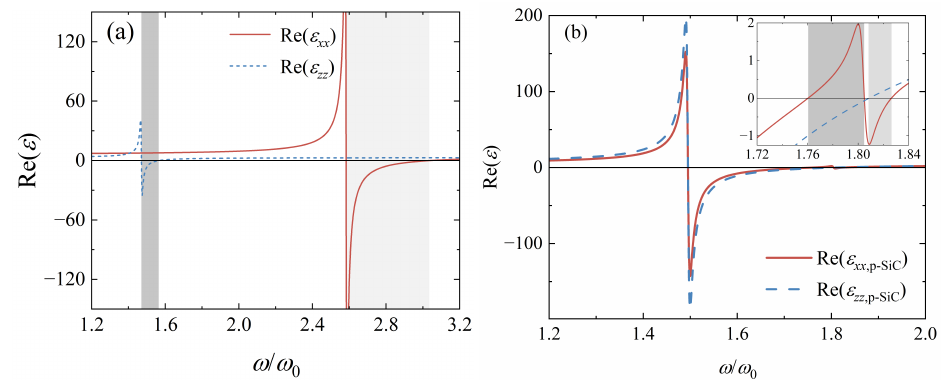
Figure 2. ( a ) The relationship between the real parts of ε l ,hBN and ω . ( b ) The relationship between the real parts of ε l ,p − SiC and ω with f = 0.3. Here l = xx , zz and grey shadow zones indicate the hyperbolic bands. The inset shows the real parts of ε l ,p − SiC from 1.72 ω 0 to 1.84 ω 0